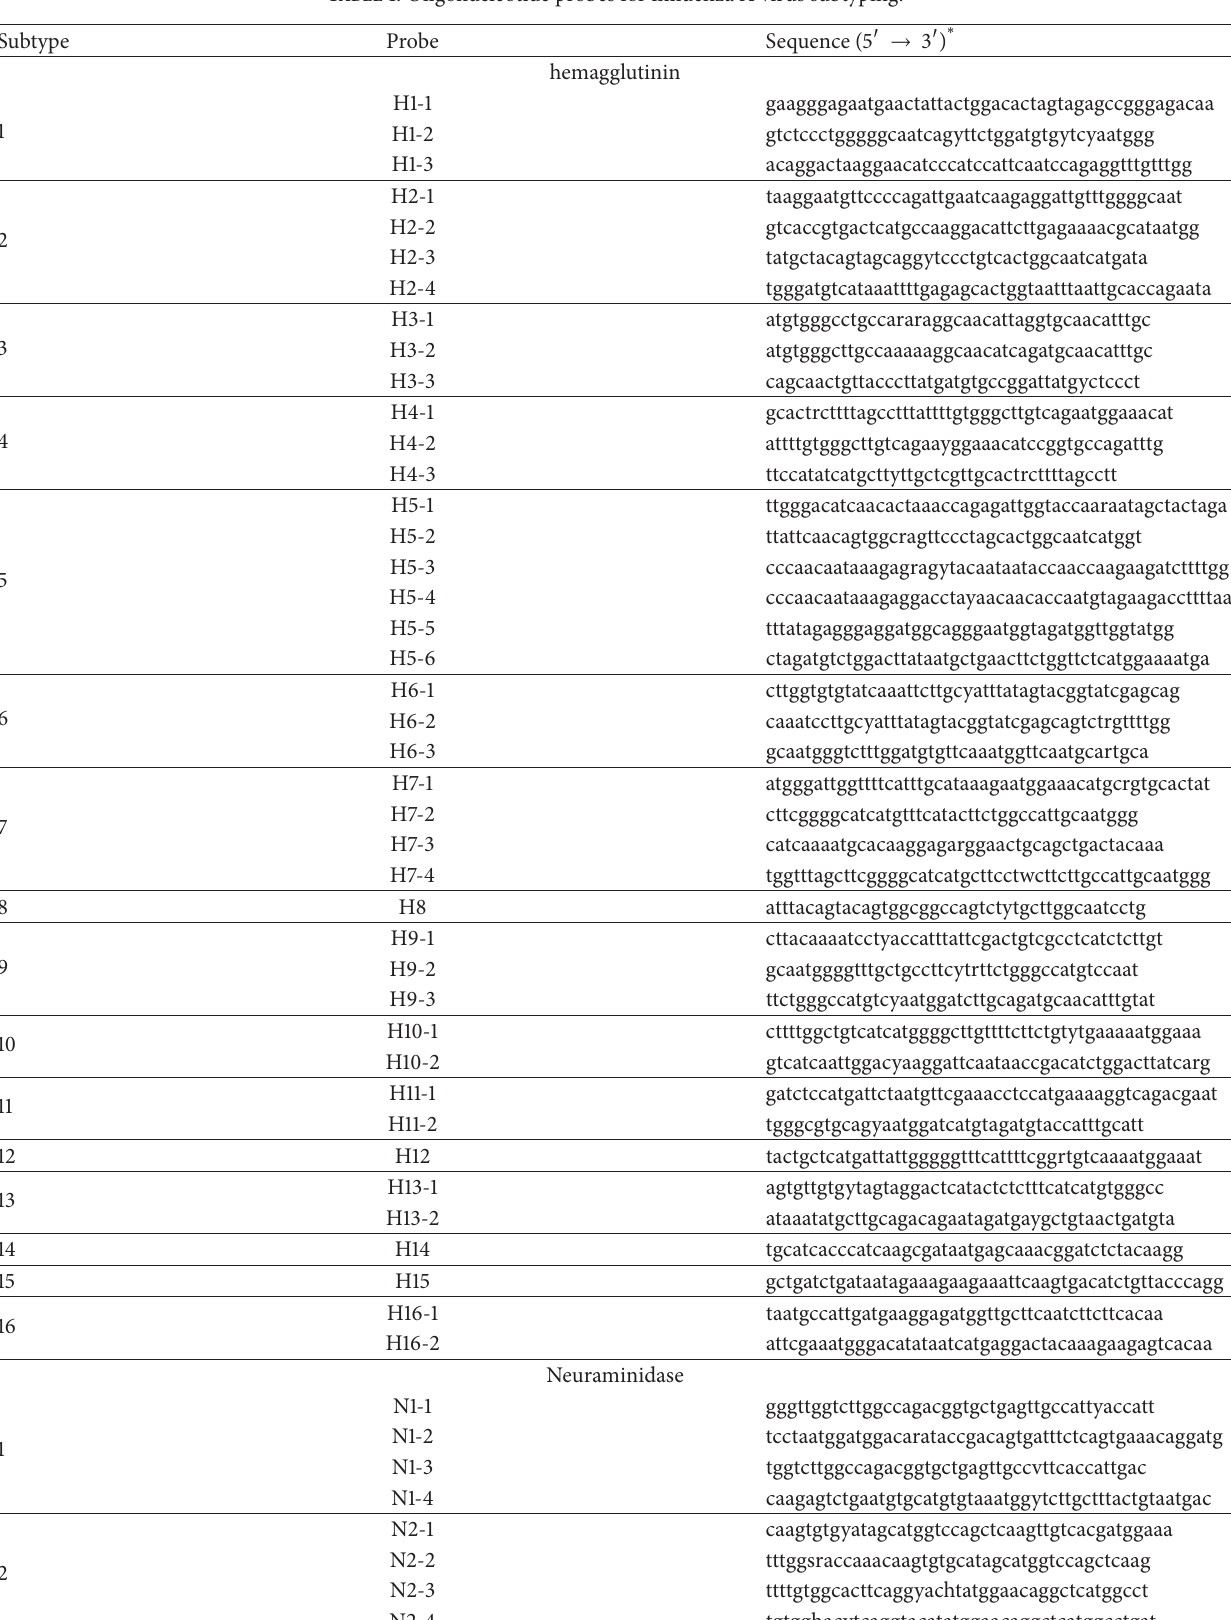
Table 1: Oligonucleotide probes for influenza A virus